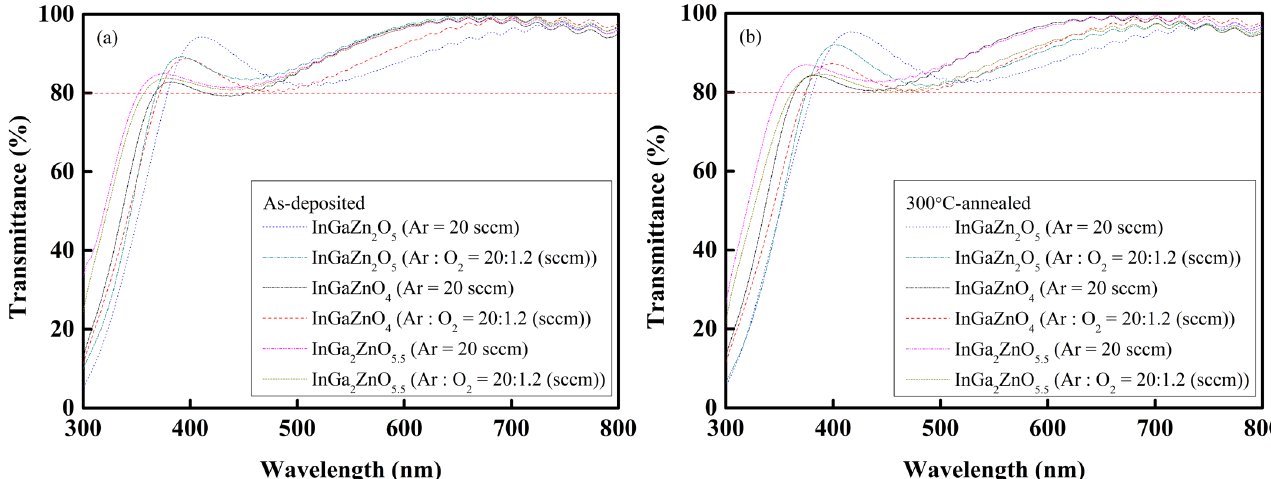
Figure 4. The transmittance profiles of ( a ) as-deposited and ( b ) 300 °C-annealed a -IGZO layers deposited with Ar = 20 sccm and Ar:O 2 = 20:1.2 (sccm) gas flow rates.